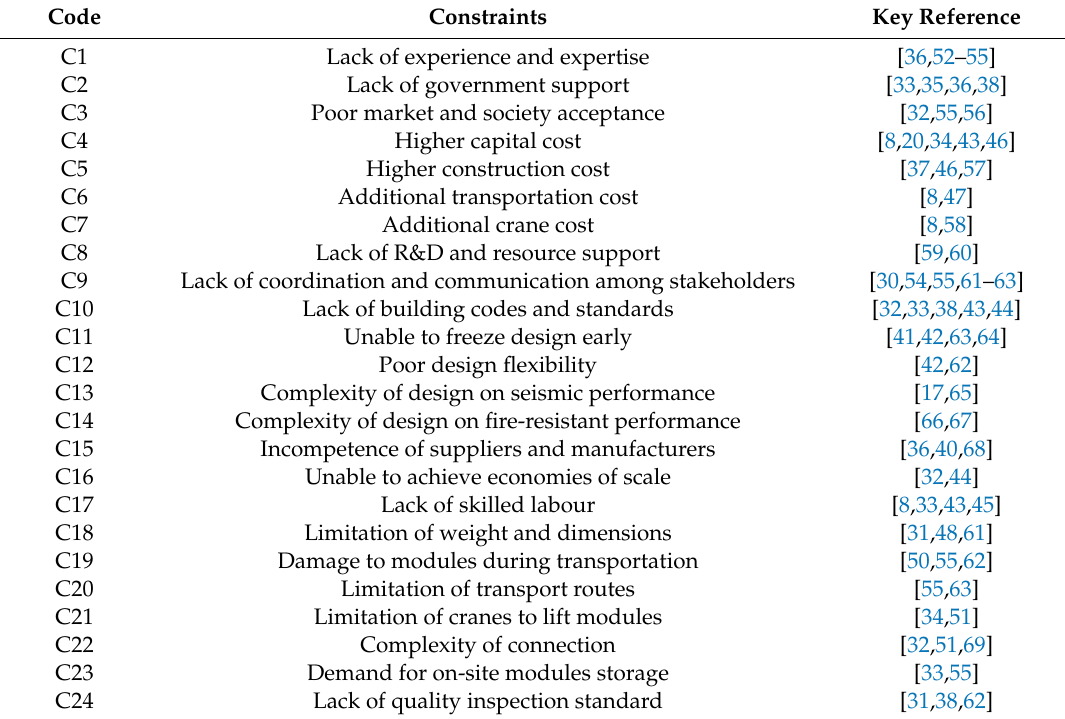
Table 1. The preliminary list of constraints hindering the development of modular buildings.